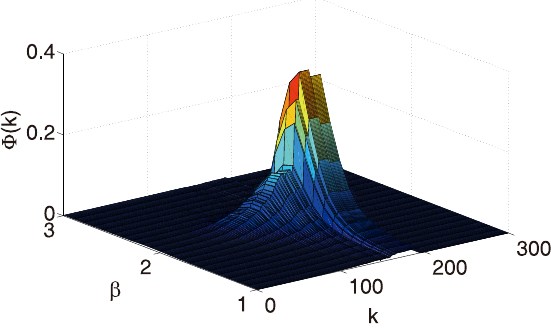
Figure 6. Rich club coefficient W ( k ) for the network of the information transfer as a function of b and the degree k